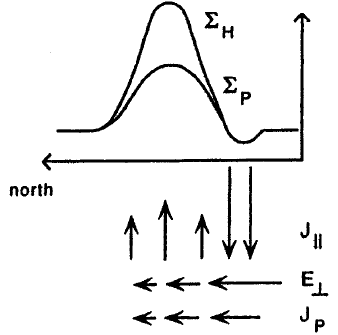
Fig. 6. A schematic model of an evening-sector arc (from Aikio,